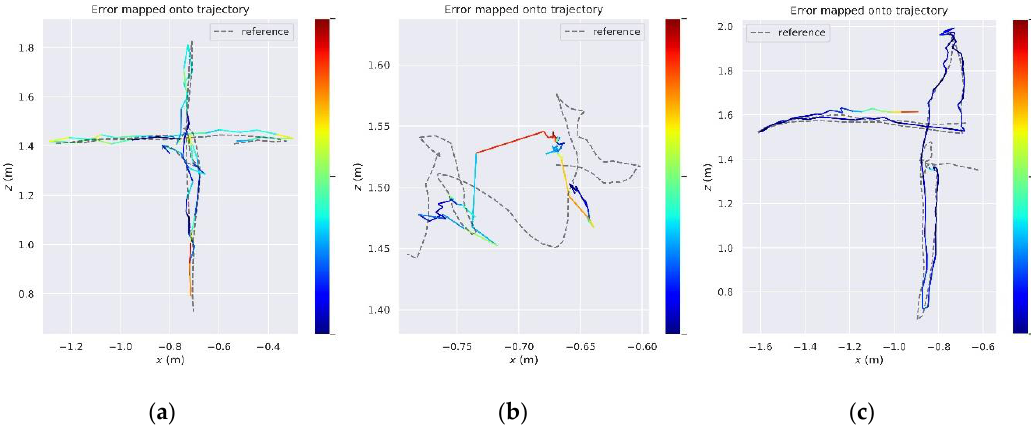
Figure 8. Heat maps of the positioning trajectory of Dynamic-DSO in three sequences. ( a ): The estimated trajectory heat map on fr3_walking_xyz. ( b ): The estimated trajectory heat map on fr3_walking_rpy. ( c ): The estimated trajectory heat map on fr3_walking_halfsphere. DSO cannot complete initialization in these three dynamic sequences, so it cannot give positioning results.